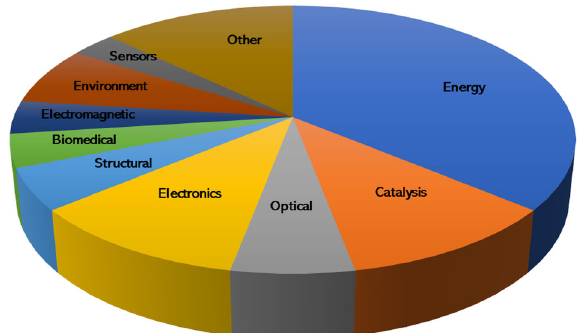
Fig. 4 Applications of MXenes. The circular pie chart demonstrates the proportion of published work within apiece explored character- istic for MXenes